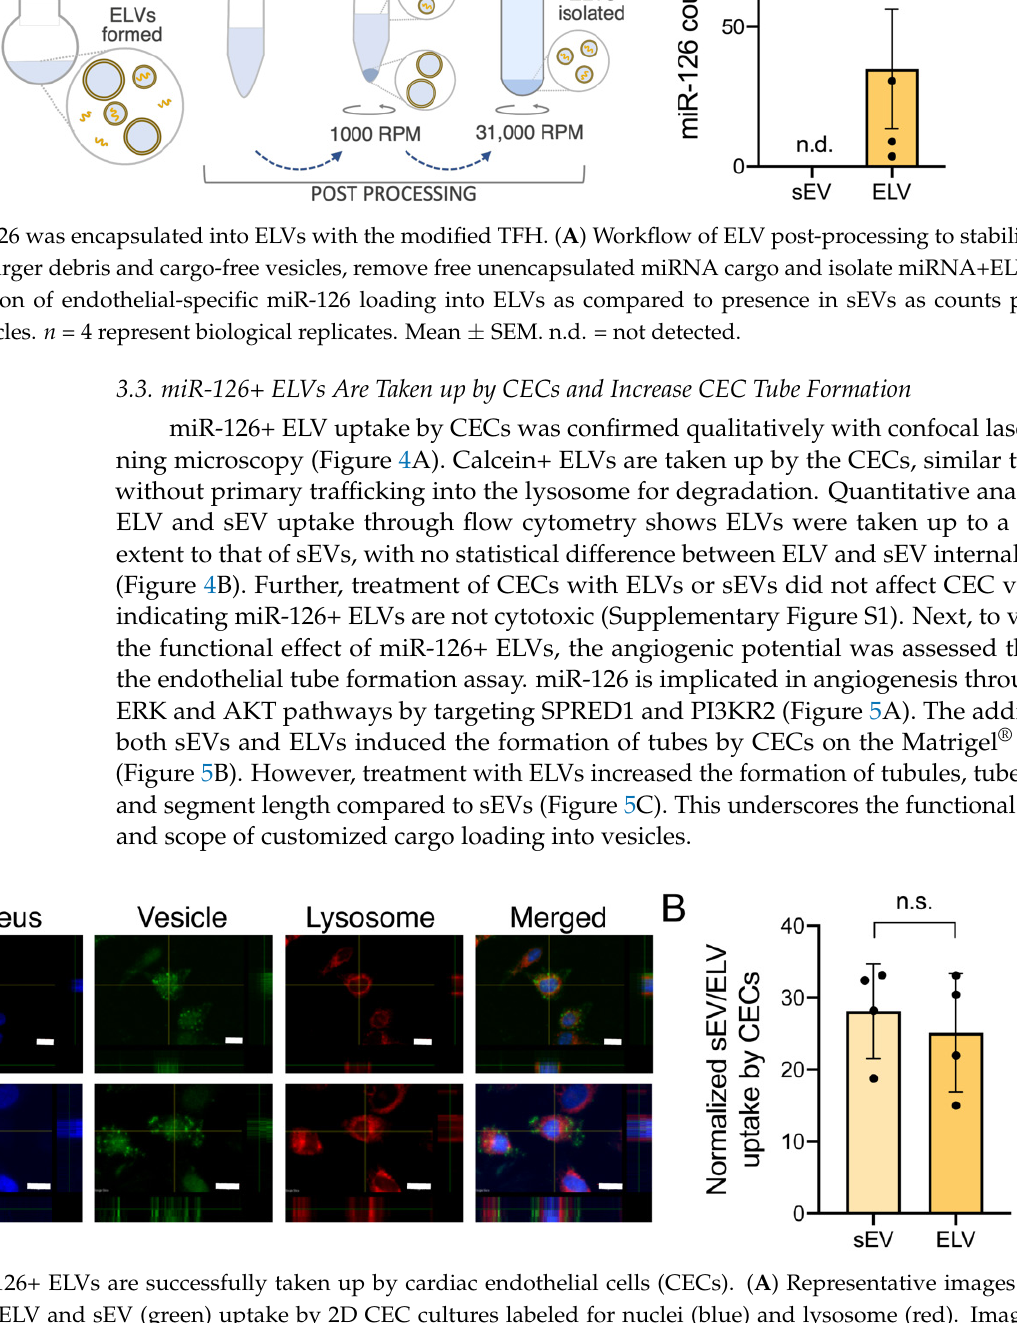
Figure 5. miR-126+ ELVs induce pro-angiogenic response in CECs. ( A ) Schematic of miR-126 mechanism of action for angiogenesis. VEGF: vascular endothelial growth factor; RAF1: rapidly accelerated fibrosarcoma proto-oncogene; ERK: extracellular signal-regulated kinase; AKT: protein kinase B; PI3K: Phosphoinositide 3-Kinase. ( B ) CECs (green) treated with miR-126+ ELVs or sEVs incubated on Matrigel form tubes after overnight incubation. CECs treated with calcein-AM.